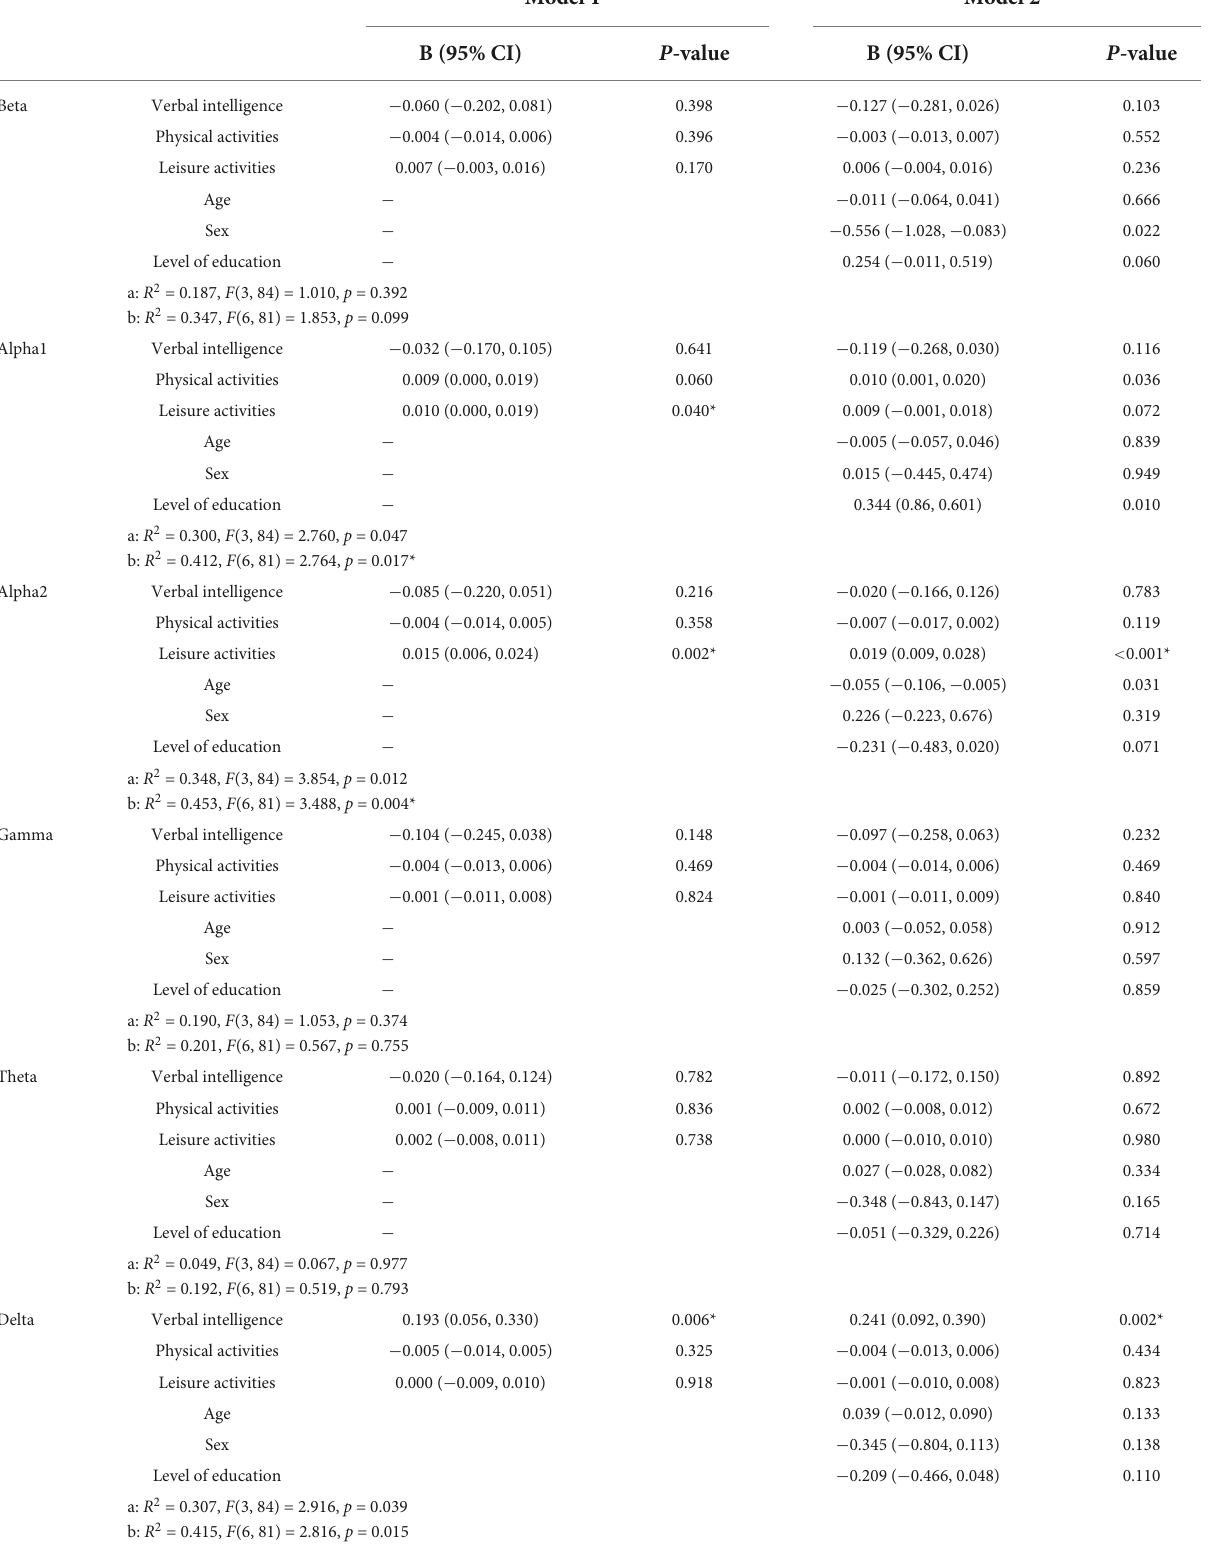
TABLE 4 Multiple linear regression analysis with resting-state EEG components as